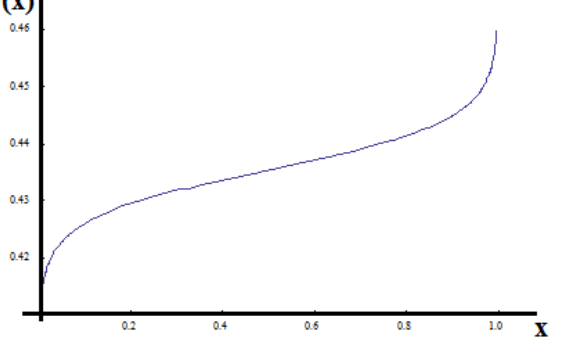
Figure 8. The non-dimensional displacement of the symmetric fractional fractal bar of order γ = 0.63.